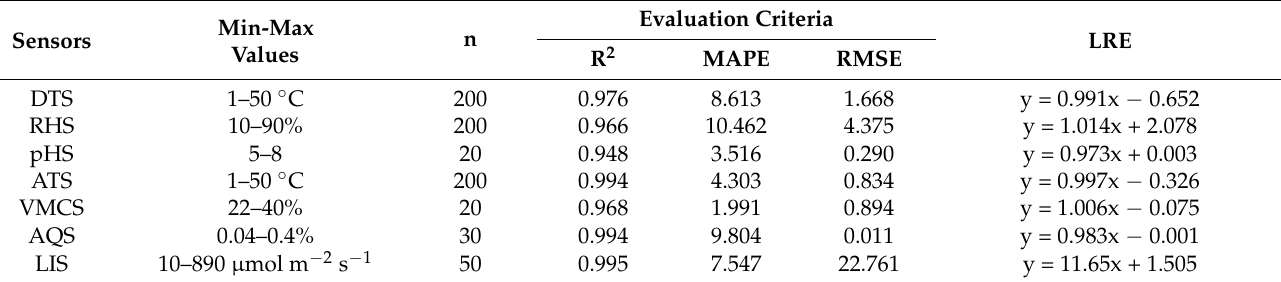
Table 1. Validation of the digital DHT22 temperature sensor (DTS), RH sensor (RHS), analog DX-250 pH sensor (pHS), analog LM35 temperature sensor (ATS), analog VH400 volumetric soil mois- ture content sensor (VMCS), analog MQ-135 air quality sensor (AQS), and FUT3101 light intensity sensor